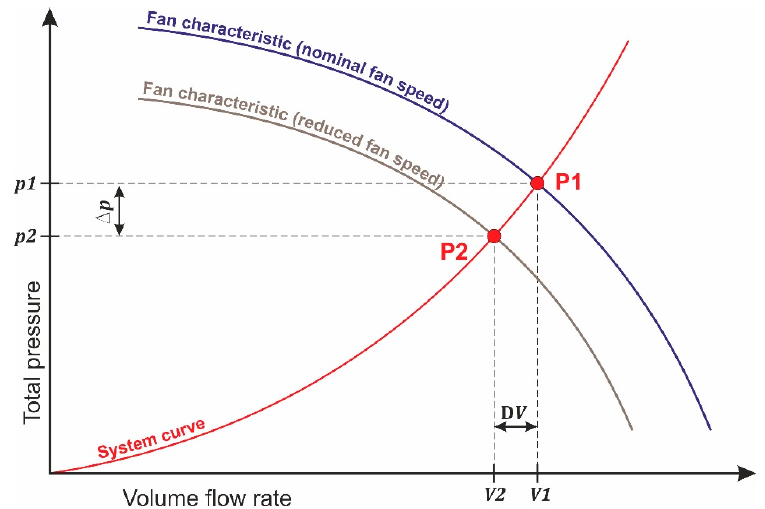
Figure 2. Idea of regulation by throttling.